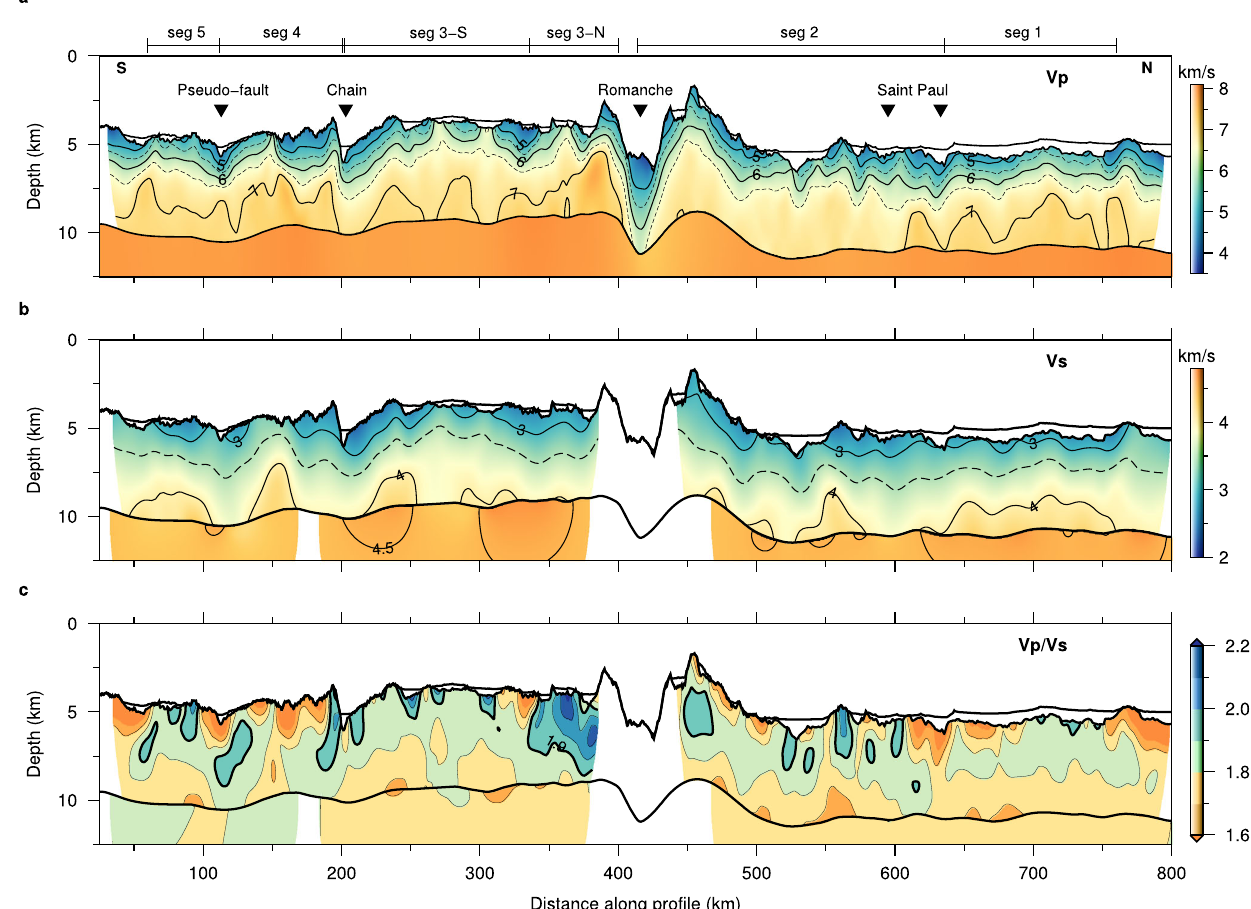
Fig. 3 | Crustal and upper mantle velocity models. Inverted P-wave velocity (Vp) model ( a ), S-wave velocity (Vs) model ( b ), and Vp/Vs ratio ( c ). The distance ranges of Segments 1 to 5 are marked at the top of a . The velocity colour scale for each fi gure is shown on the right. seg: